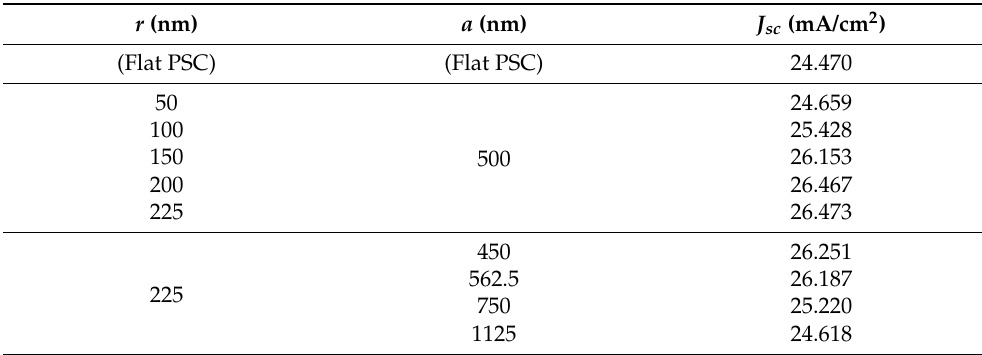
Table 2. The photocurrent density ( J sc ) for certain variations of the radius ( r ) and lattice constant ( a ) of PC and flat PSC in this